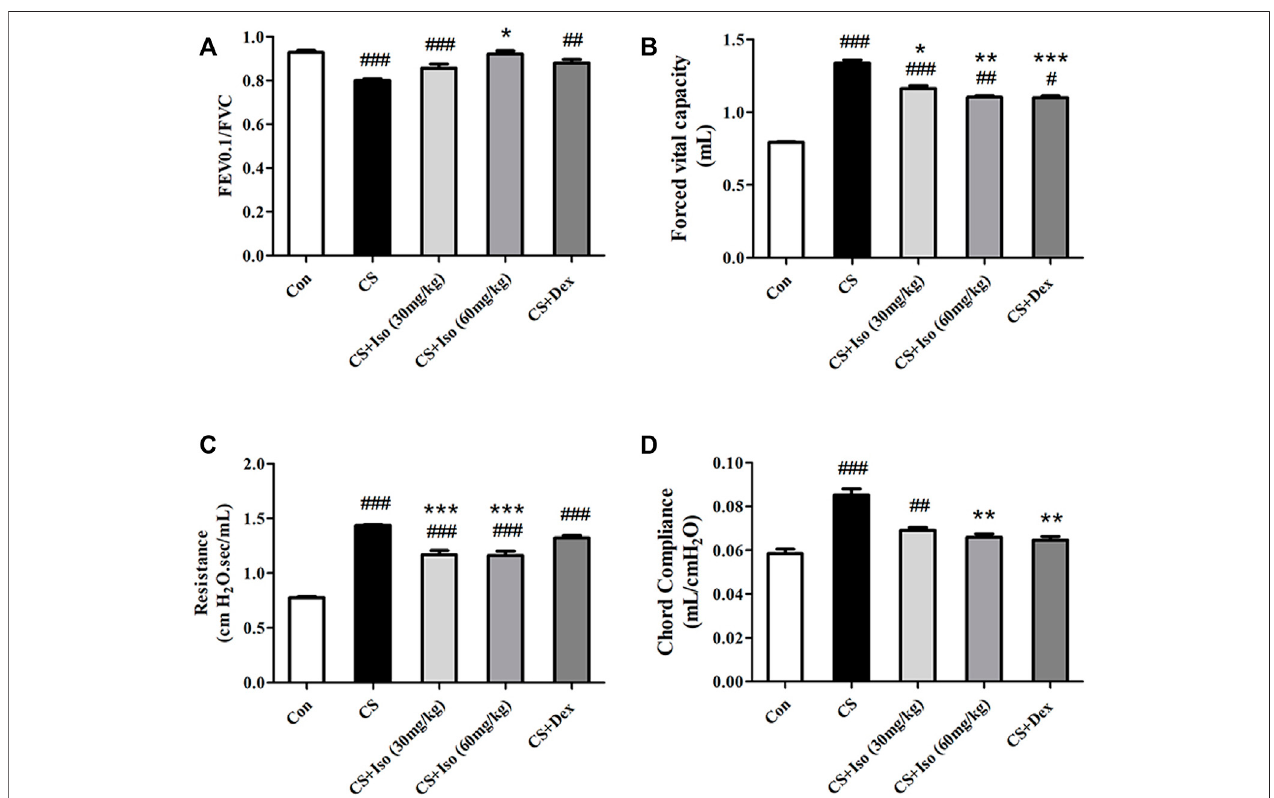
FIGURE 3 | Iso alleviates lung functions decline of CS-induced COPD mice, which was described by increasing (A) FEV0.1/FVC and decreasing (B) forced vital capacity, (C) resistance index and (D) chord compliance ( n = 5 mice per group). Data was shown as mean (±SD) (A – D) . To test for group differences one-way ANOVA (A – D) was applied. # p < 0.05, ## p < 0.01, ### p < 0.001 vs. control group and * p < 0.05, ** p < 0.01, *** p < 0.001 vs. CS